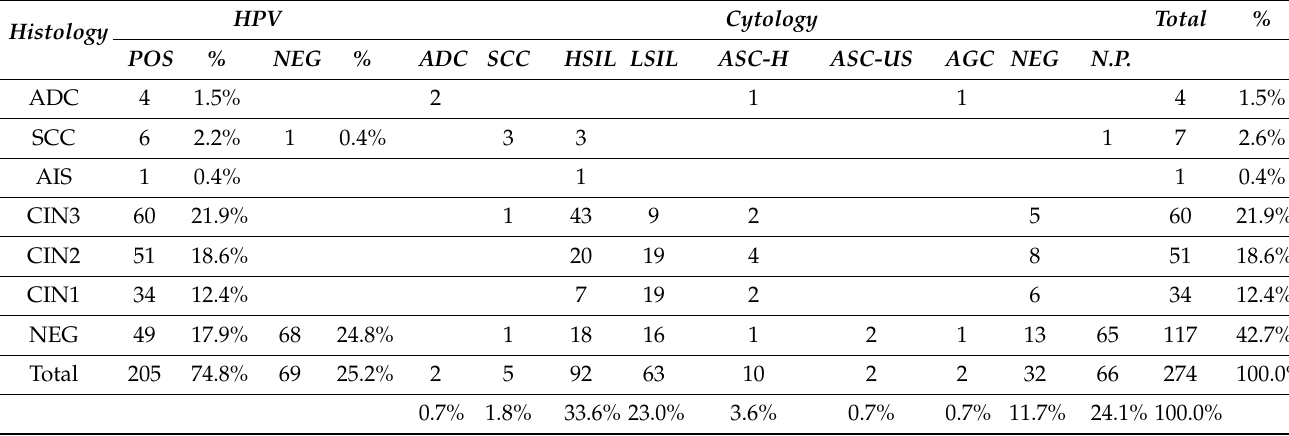
Table 1. Correlation of molecular, cytological, and histological diagnoses of the samples selected for the study.